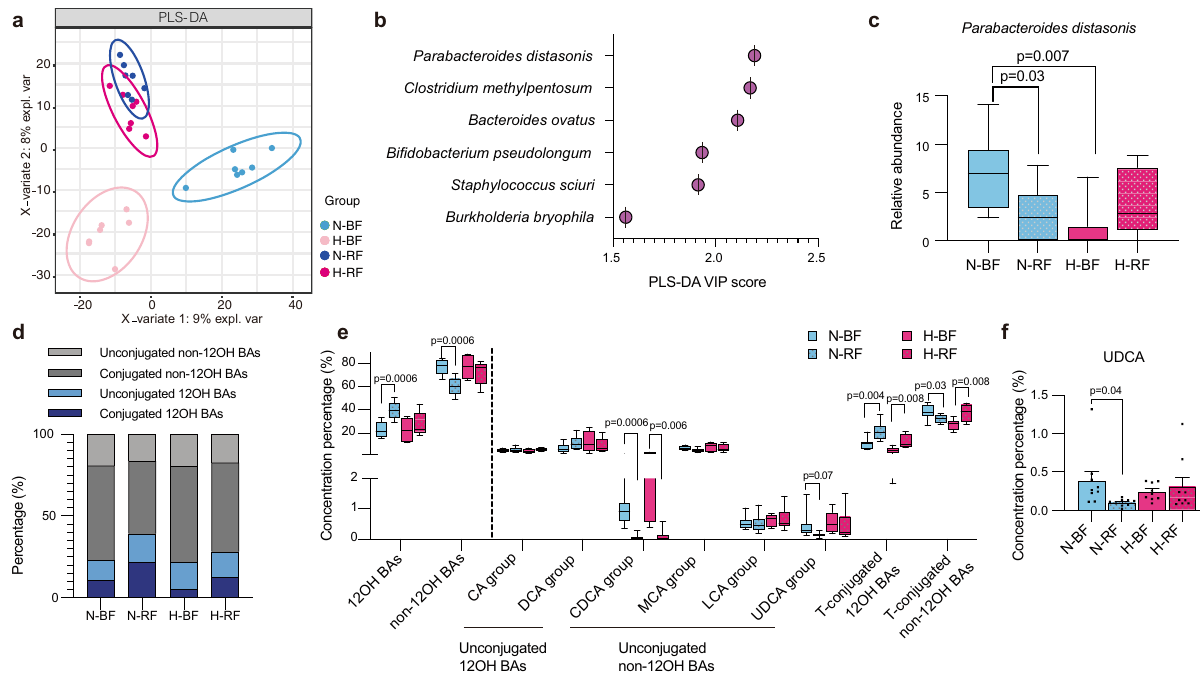
Fig. 4 The depletion of Parabacteroides distasonis and non-12OH BAs after fasting. a PLS-DA plot of the cecal microbiome in four groups, n = 7 per group. b The species rank of VIP scores of the PLS-DA analysis in chow diet. c Relative abundance of Parabacteroides distasonis among four groups. d The bar plots of the mean percentage of (non-)12OH and (un)conjugated BAs in the serum. e The BAs composition pro fi les in serum. p -values were adjusted by the FDR ’ s method. f UDCA was signi fi cantly reduced after fasting in the chow diet, data are expressed as means ± SEM. n = 9 per group. Differences were assessed by two-tailed multiple T-test in the GraphPad software. All box and whiskers plots showed the box (from the 25th to 75th percentiles), the median value (in the transverse line), and the whiskers (go down to the smallest value and up to the largest). Source data are provided as a Source data fi le. Partial least- squares discriminant analysis (PLS-DA); variable important in projection (VIP); cholic acid (CA); deoxycholic acid (DCA); chenodeoxycholic acid (CDCA); muricholic acid (MCA); lithocholic acid (LCA); ursodeoxycholic acid (UDCA); 12 α -hydroxylated bile acids (12OH BAs); non-12 α -hydroxylated bile acids (non-12OH BAs); T-conjugated